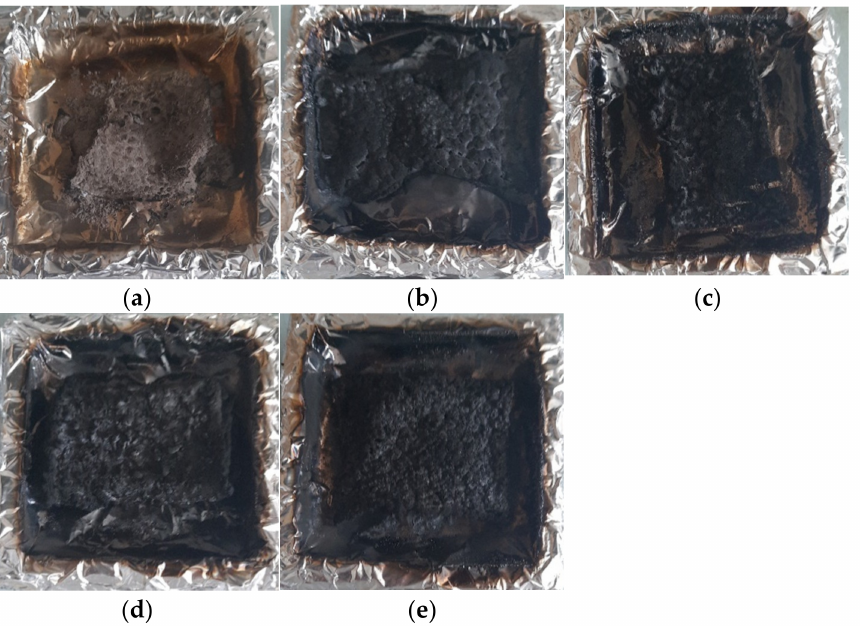
Figure 11. Photos of residue from cone calorimetry tests: ( a ) EP601 + IDA, ( b ) EP601 + IDA + B, ( c ) EP601 + IDA + DEHPA-Al, ( d ) EP601 + IDA + DPPA-Al, ( e ) EP601 + IDA +